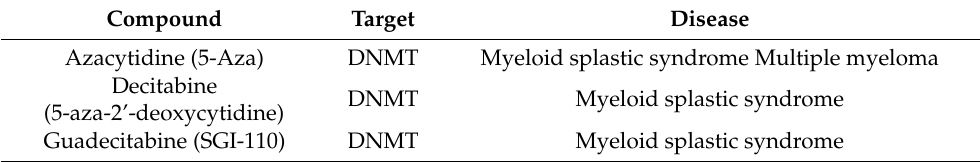
Table 2. List of DNMT1 compounds and their